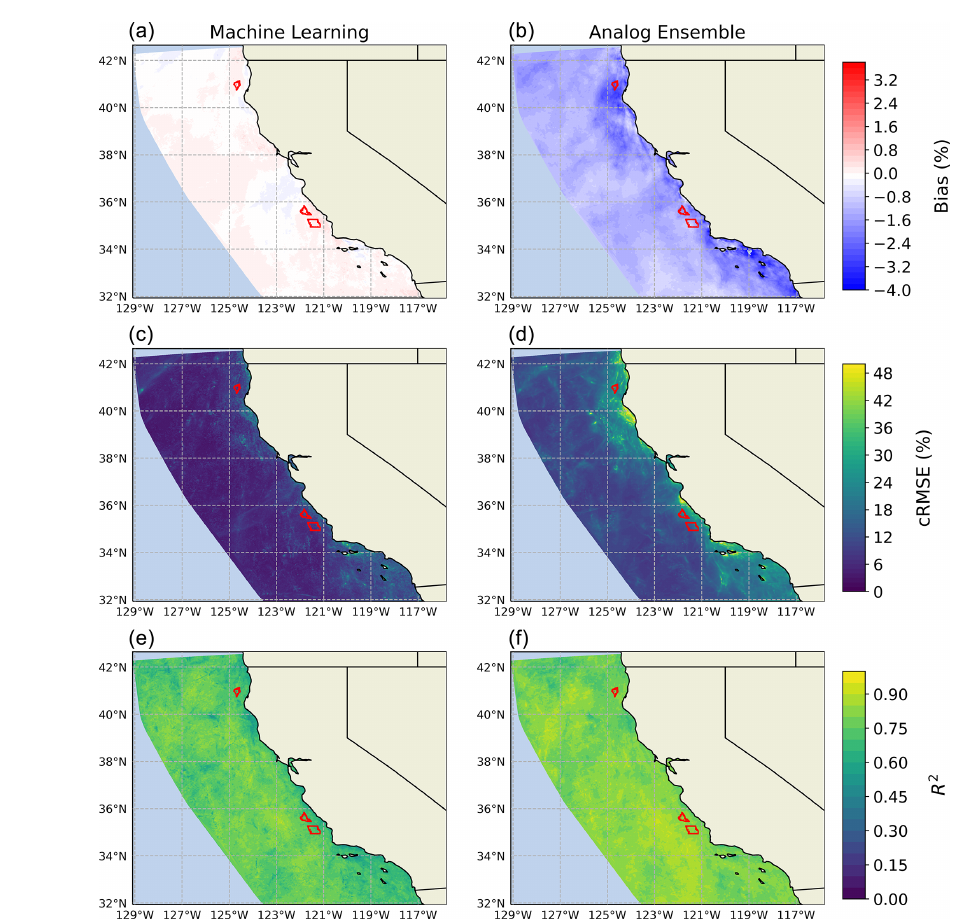
Figure 4. Map of testing bias, cRMSE, and R 2 determination coefficient from the GBM model (a, c, e) and the AnEn approach (b, d, f) . The wind energy lease areas are highlighted in